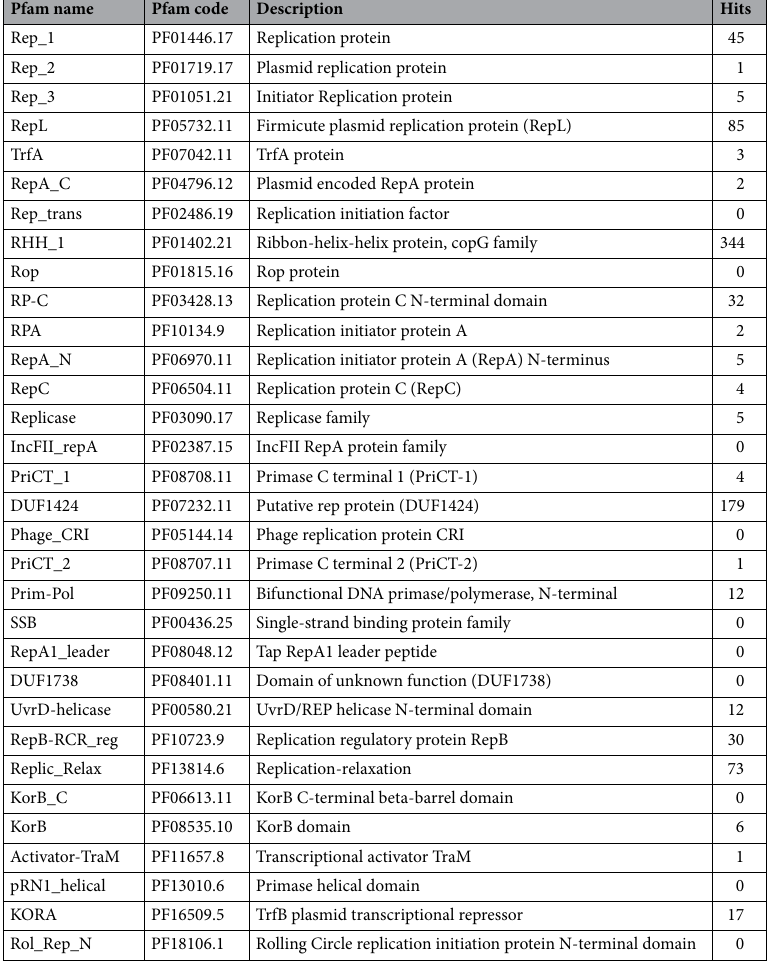
Table 1. Plasmid replication-related Pfam in the Diamante Lake plasmidome.